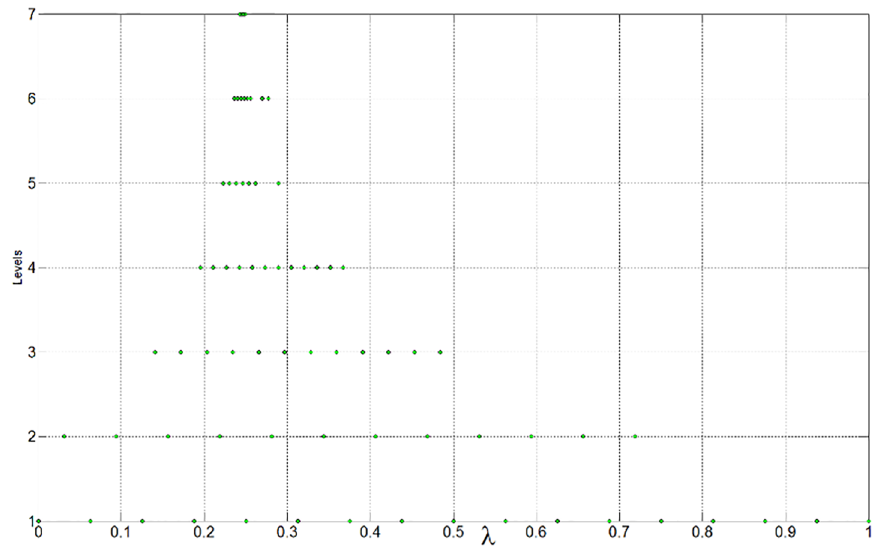
Fig 6. Distribution of the collocation points on each level.